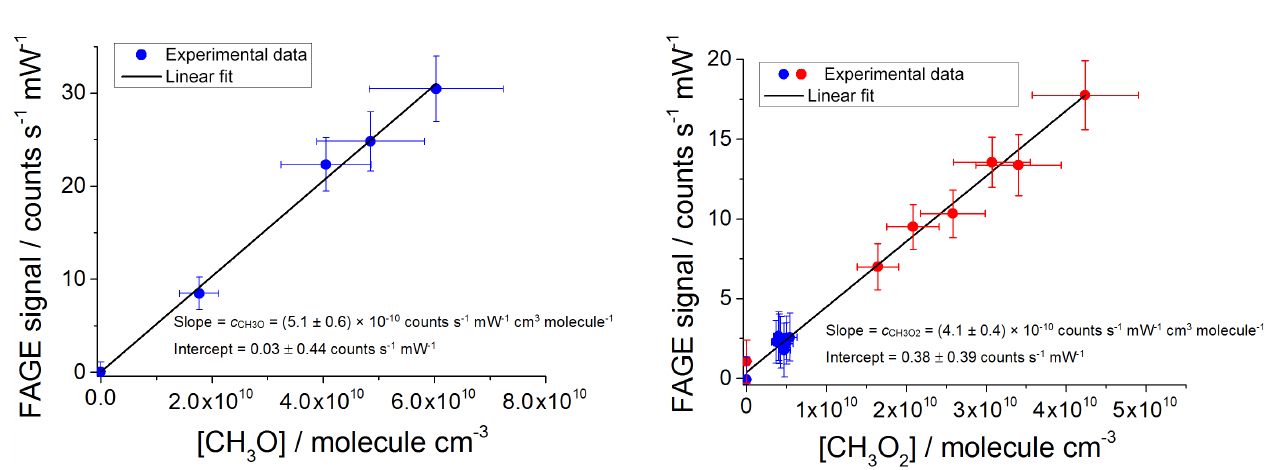
Figure 6. FAGE calibration for CH 3 O 2 at atmospheric pressure and 293K. The data were obtained by three separate experiments: two of them generating [CH 3 O 2 ] ∼= 4.5 × 10 9 moleculecm − 3 in the calibration flow tube (blue circles); laser power P = 9 . 5 ± 0 . 3mW and 11.6 ± 0.4mW respectively and one experiment using [CH 3 O 2 ] in the range of 1.5–4.5 × 10 10 moleculecm − 3 (red cir- cles); P = 9.2 ± 0.2mW. The pressure in the FAGE detection cell was maintained at 2.65 ± 0.05Torr in all experiments. Averaging time per point = 120s. The error limits in [CH 3 O 2 ] and the FAGE signal for the x and y axes respectively are representative for the 1 σ overall uncertainty, which contains the total systematic and sta- tistical errors. The error limits shown in the legend are the standard errors in the slope and intercept of the fit to the experimental